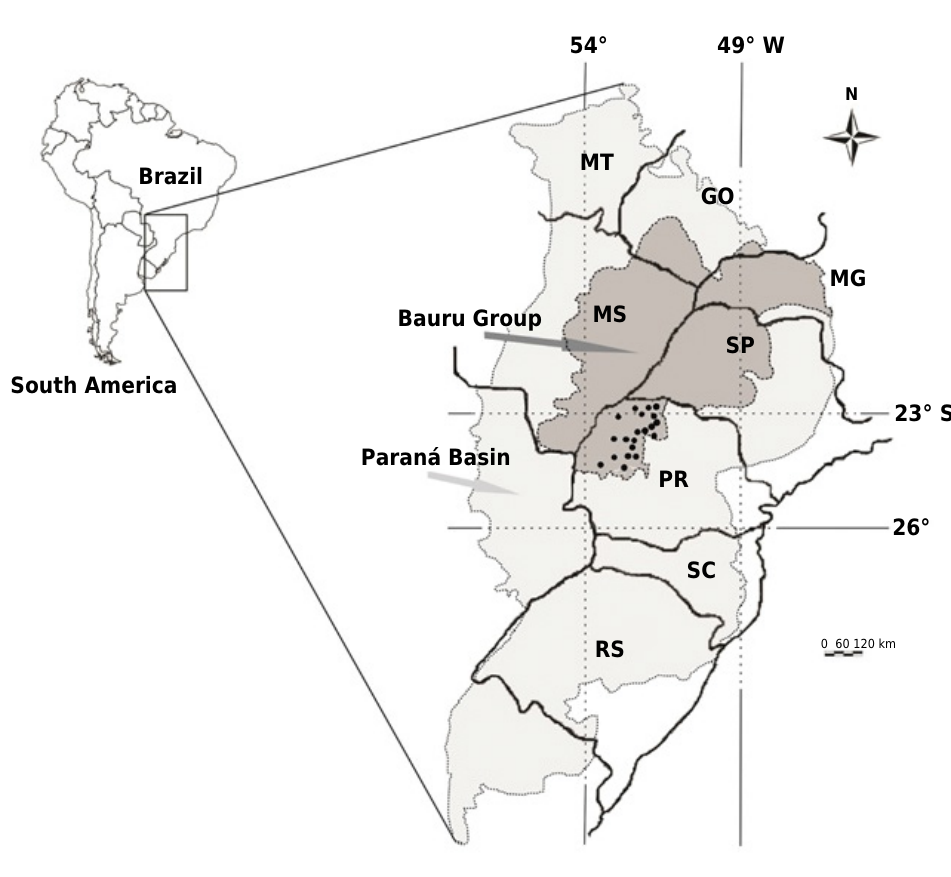
Figure 1. Distribution of the sampling sites in the state of Paraná (PR), Bauru Group, and Paraná River Basin, modified from Fernandes and Coimbra (2000). The points indicated in the northwest (•) of Paraná state (PR) represent the sampling